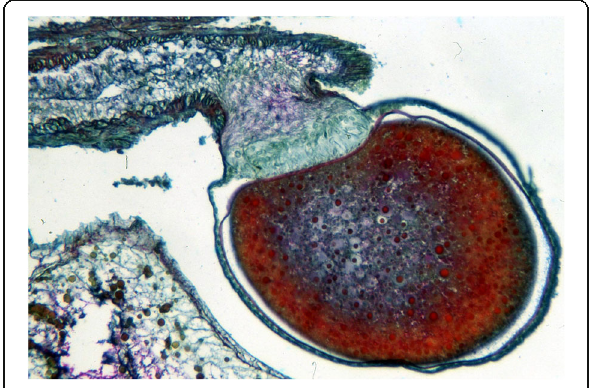
Fig. 8 Histological section showing the development of the apoikogenic euscorpiid Euscorpius